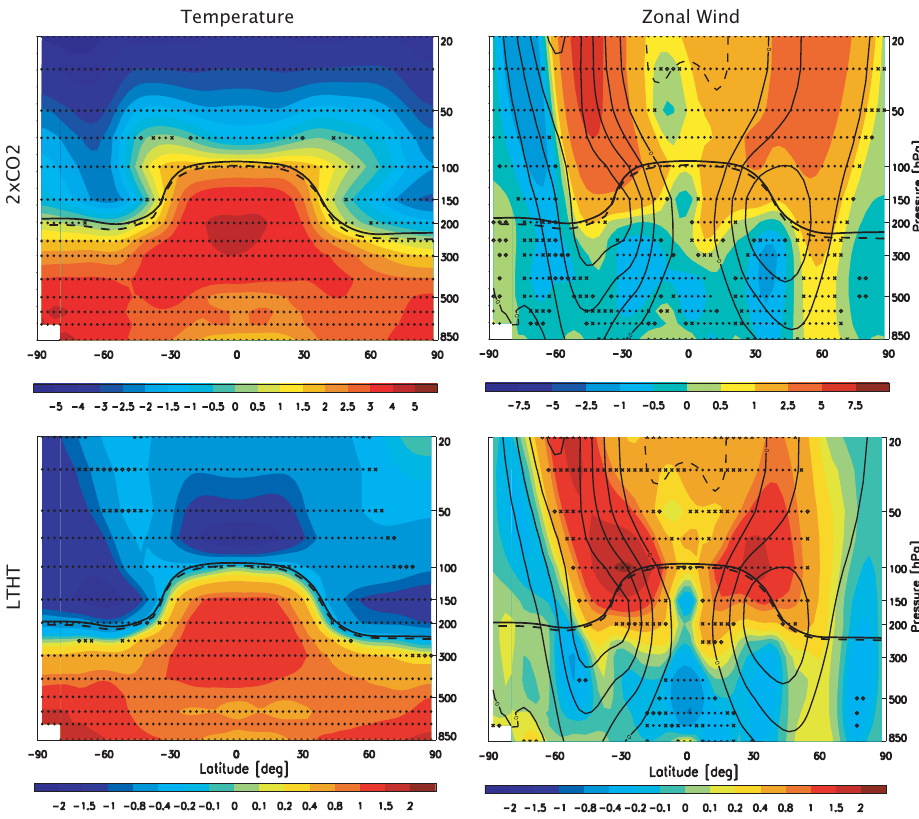
Fig. 7. 2 × CO2 (top) and LTHT (bottom) annual mean temperature (left) and zonal wind (right) response. LTHT results, and significance symbols, are as in Fig. 3. Note contour differences between 2 × CO2 and